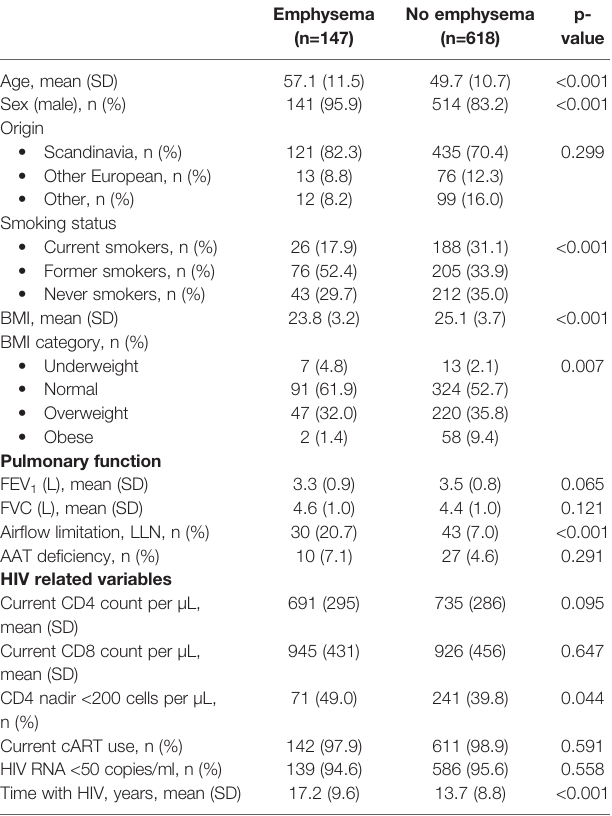
TABLE 1 | Clinical characteristics of people living with HIV with and without